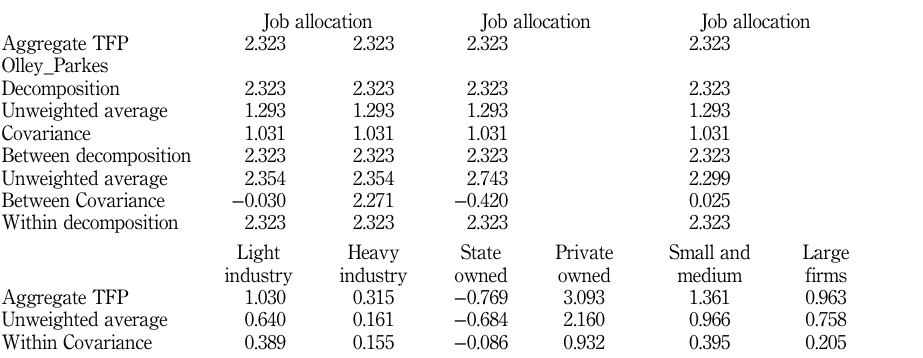
Table III. Static